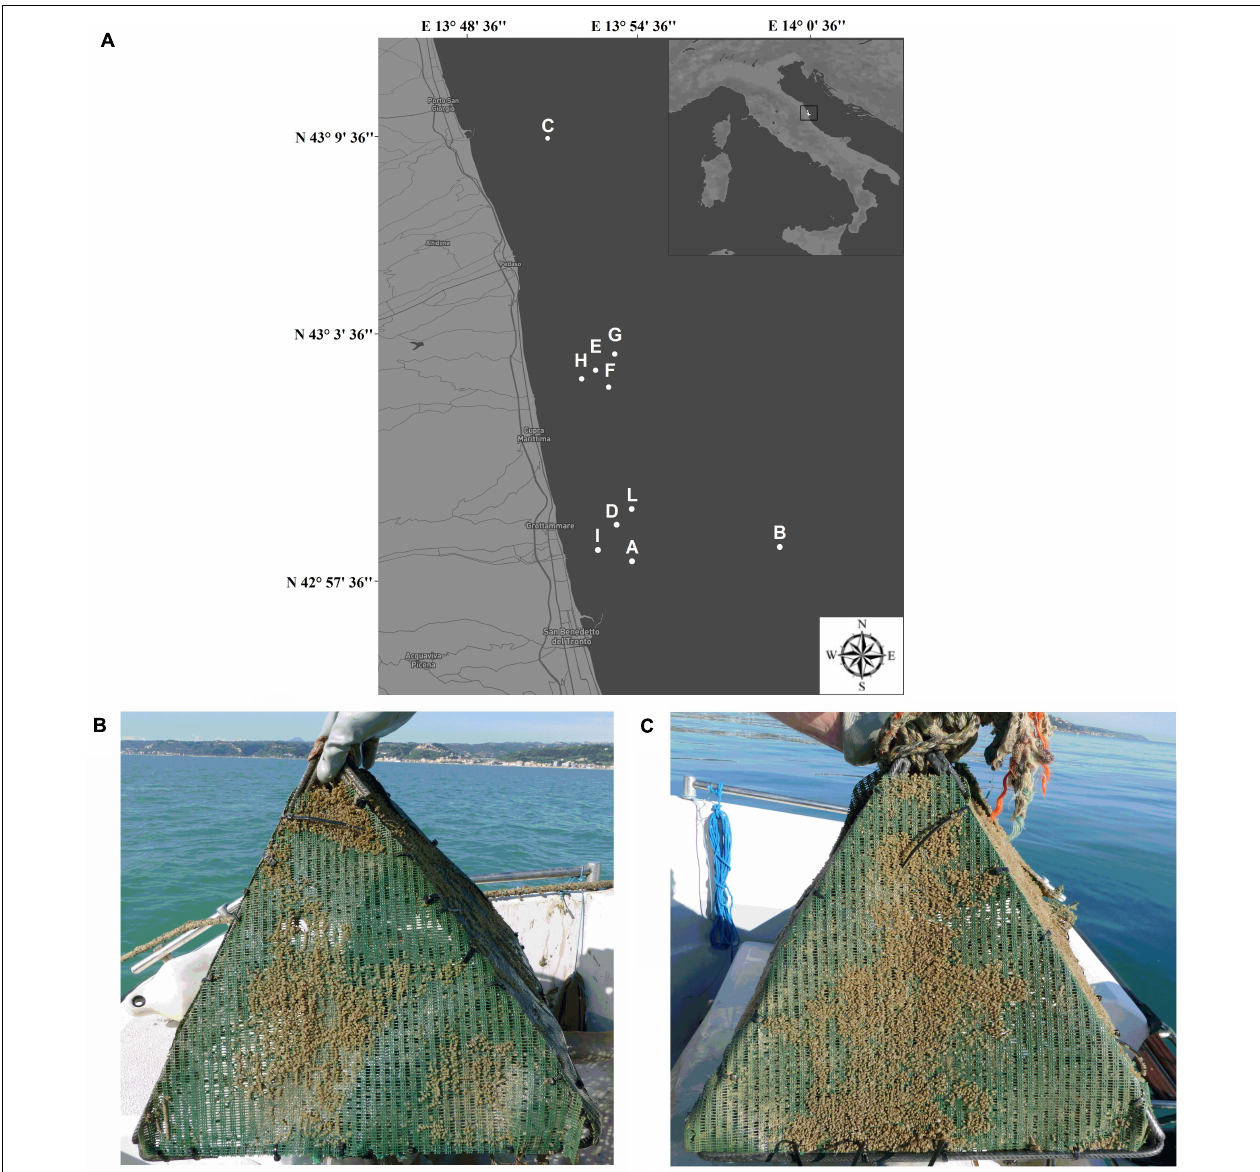
FIGURE 1 | Map of the study area and monitoring locations (A) . Representative images of artificial substrates during the first (B) and the second monitoring (C)